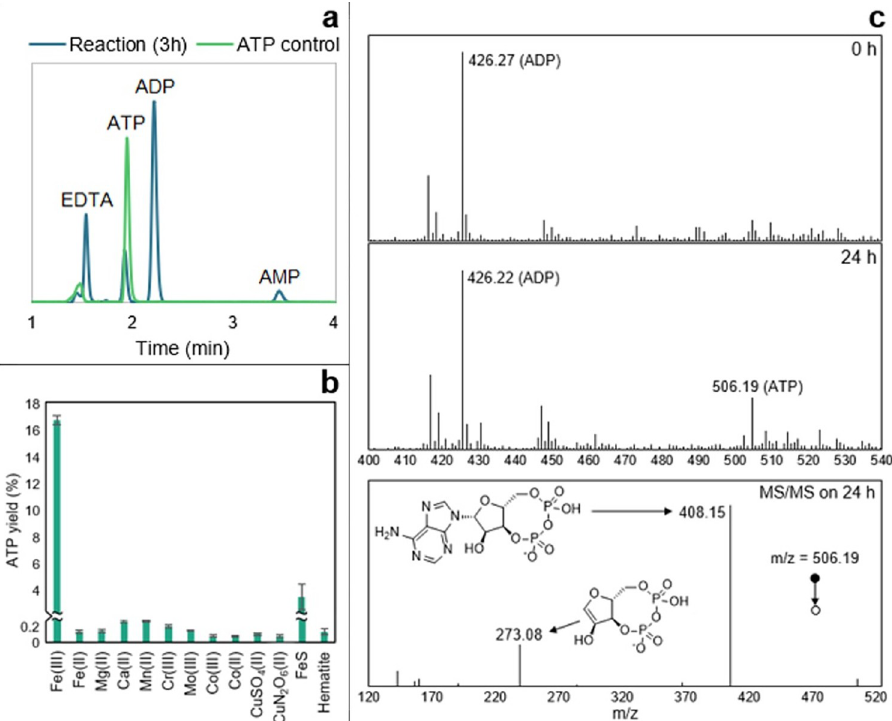
Fig 1. ATP synthesis with metal ion catalysts. ( a ) HPLC trace of ATP control (0.7 mM) and ATP produced by the reaction ADP (1 mM) + AcP (4 mM) + Fe 3+ (500 μ M) at 30˚C and pH approximately 5.5–6. ( b ) Test of reaction ADP (1 mM) + AcP (4 mM) at 30˚C and pH approximately 5.5–6 with Fe 3+ (Fe 2 (SO 4 ) 3 ), Mg 2+ (MgCl 2 ), Ca 2+ (CaCl 2 ), Mn 2+ (Mn(NO 3 ) 2 ), Cr 3+ (Cr(NO 3 ) 3 ), Mo 3+ (MoCl 3 ), Co 3+ ([Co(NH 3 ) 6 ]Cl 3 ), Co 2+ (CoCl 2 ), CuSO 4 , Cu(NO 3 ) 2 , FeS clusters (500 μ M), and hematite (Fe 2 O 3 , 50 mg). The bars represent the ATP yield after 5 h. N = 3 ± SD. ( c ) Mass spectrometry analysis on a reaction sample at t = 0 h (upper panel) and 24 h (middle panel). The MS/MS spectrum and proposed structures of the products of the fragmentation of the ATP mass detected at 24 h (m/z = 506.19) is shown in the lower panel and was confronted to commercial standards and public data [137]. Conditions: ADP (1 mM) + AcP (4 mM) + Fe 3+ (500 μ M) at 30˚C and pH approximately 5.5–6. The data underlying this figure can be found in Table A–C in S1 Data (sheet